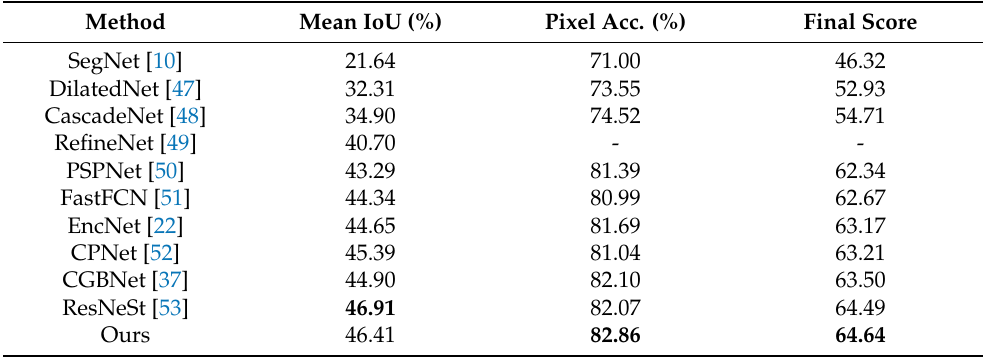
Table 2. Comparison with state-of-the-art methods on ADE20K dataset. Our method outperforms the state-of-the-arts on pixel accuracy.